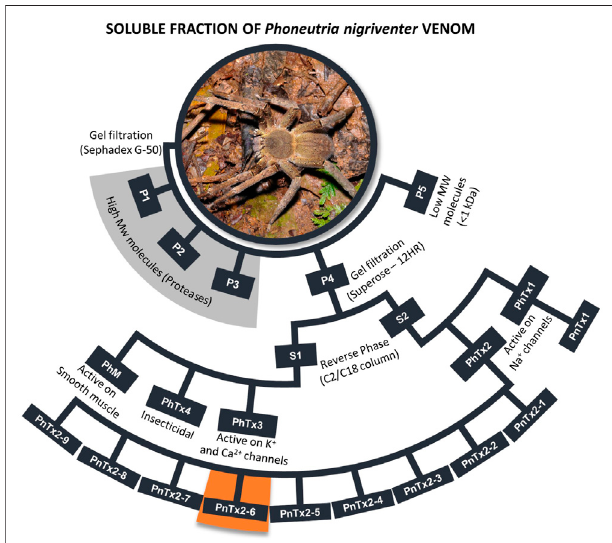
FIGURE 1 | Scheme of puri fi cation P. nigriventer spider venom summarizing the general activities of each fraction. All toxins obtained from fraction PhTx2 were showed, including PnTx2-6 highlighted in orange. More detailed studies can be found in Peigneur et al. (2018). The names of the toxinsarepresentedasinthe fi rstpuri fi cationofthevenom.Thenomenclature suggested by King et al. (2008) for these toxins can be found in the Arachnoserver database